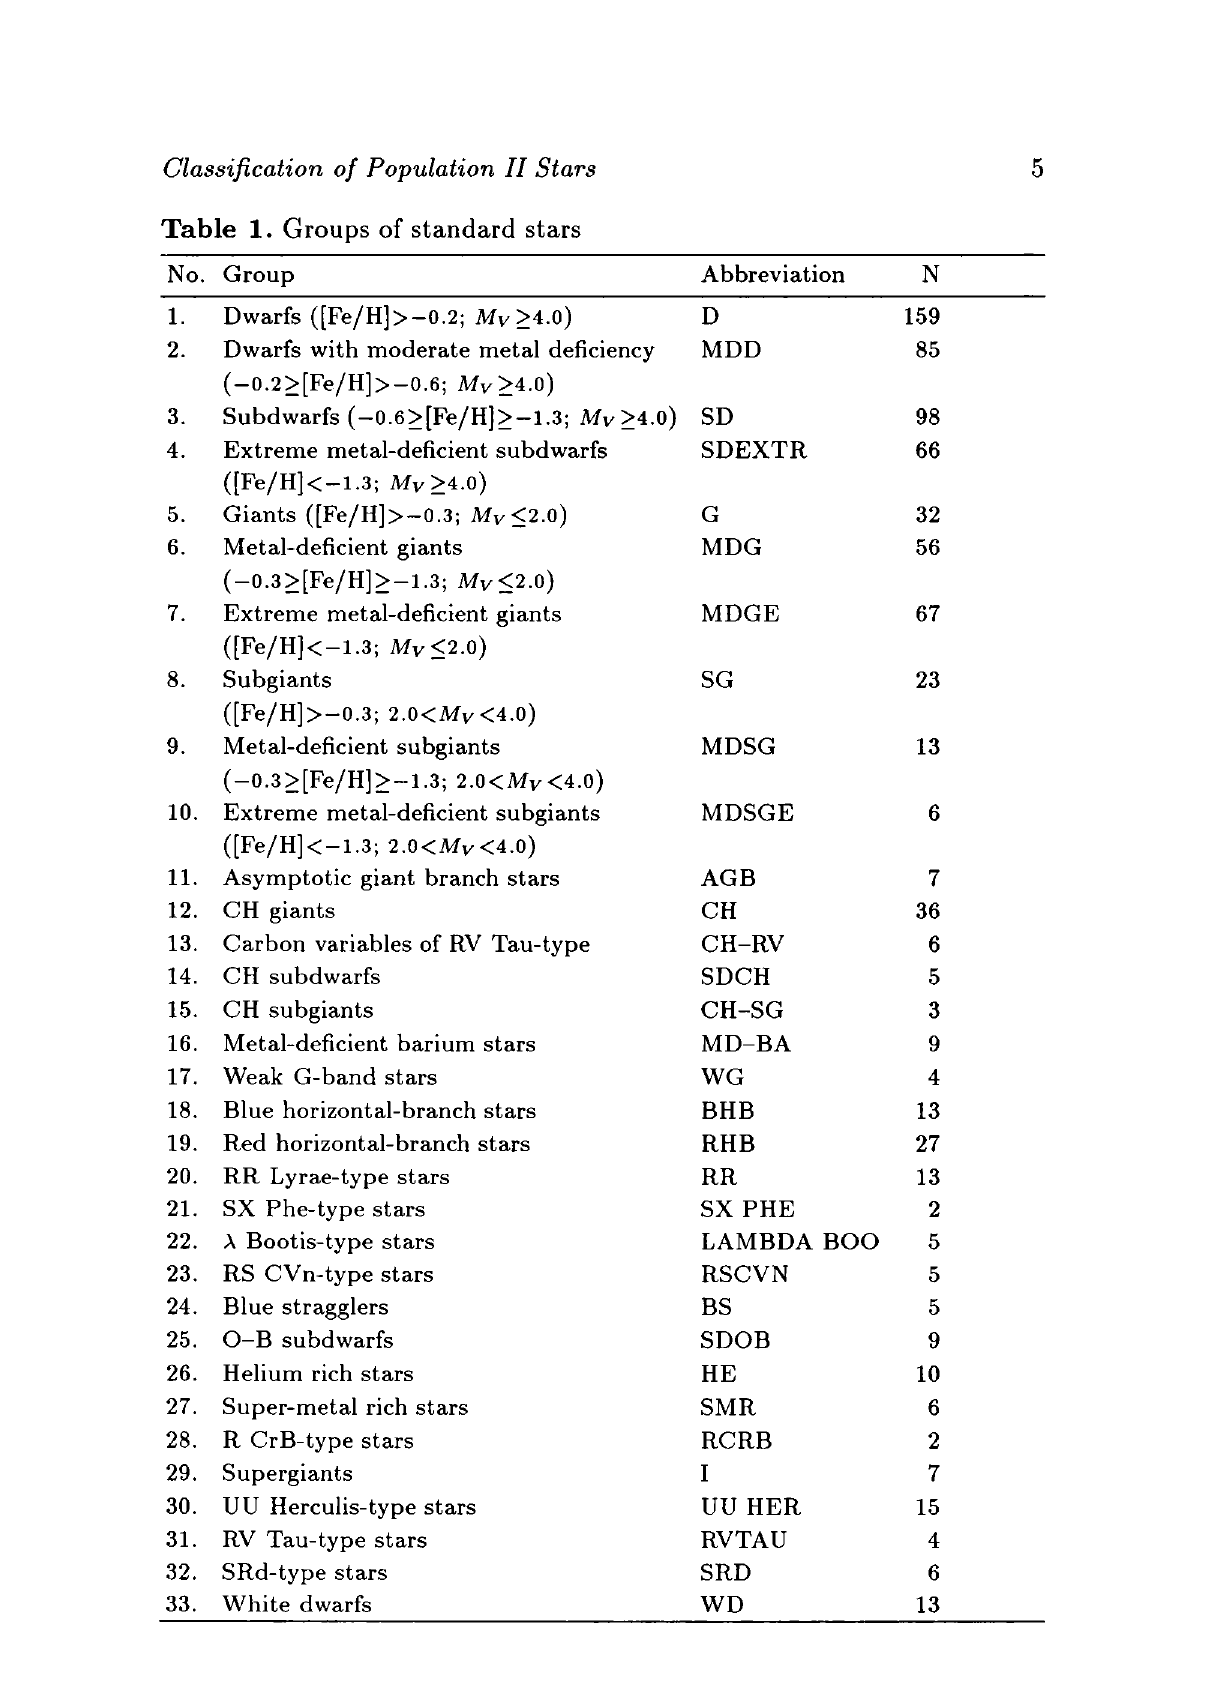
Table 1. Groups of standard